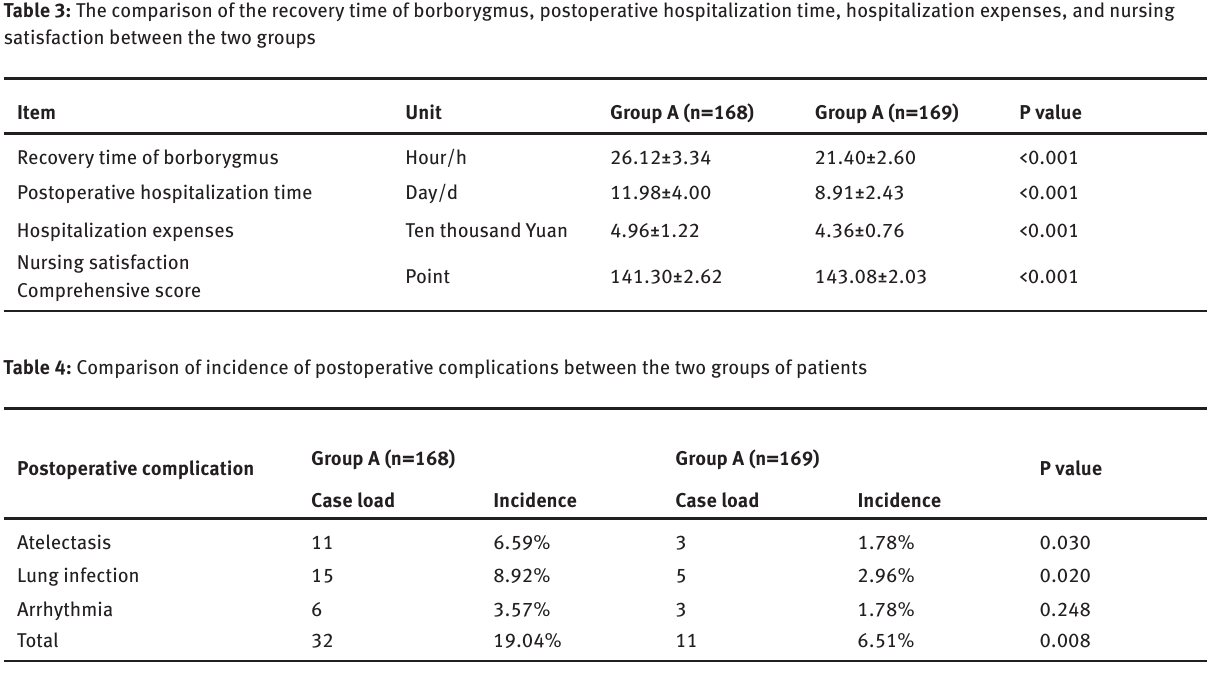
Table 5: Comparison of postoperative NRS between the two groups of patients